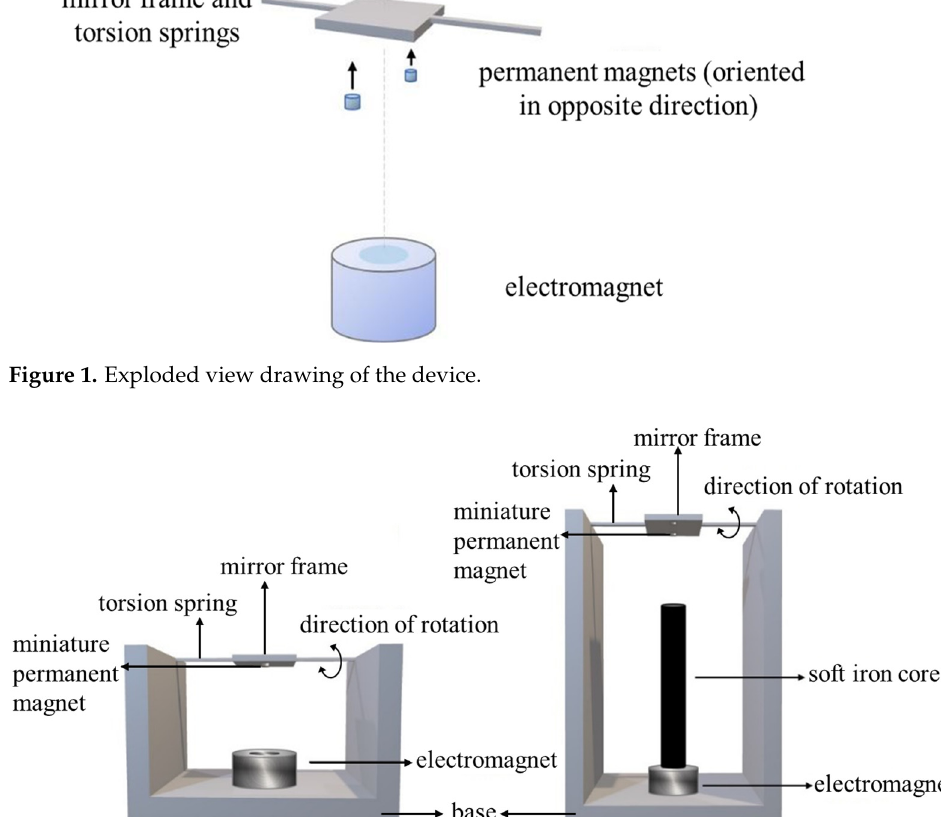
Figure 1. Exploded view drawing of the device.